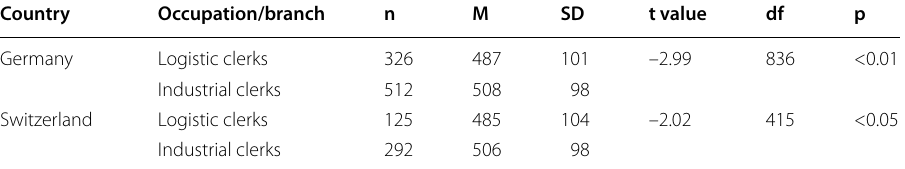
Table 5 Country-specific competence scores by commercial occupation/branch Country